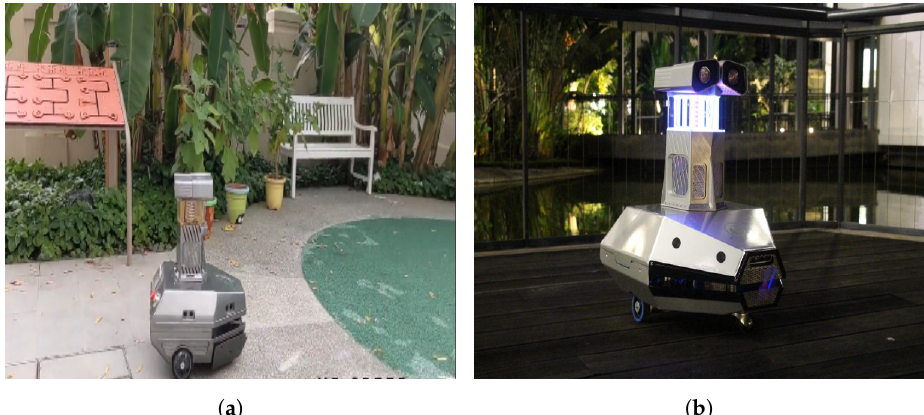
Figure 8. Testing environment. ( a ) ‘Dragonfly’ robot in garden (morning). ( b ) ‘Dragonfly’ robot in SUTD campus (evening).